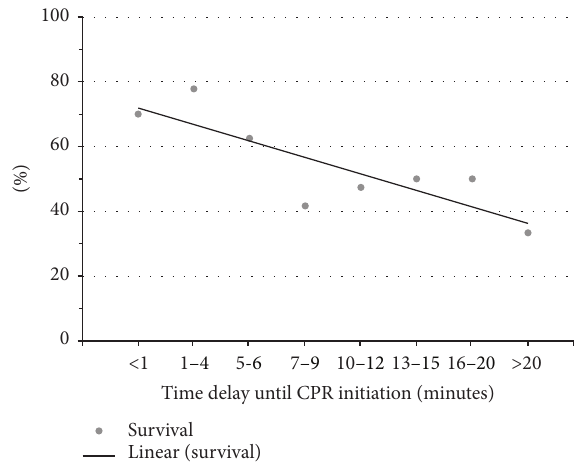
Figure 3: Effect of bystander CPR on survival. Patients were divided into those that received bystander CPR and those that did not (top pie chart). Each group was further evaluated for outcome of survival in association with having received bystander CPR (bottom right pie chart) and not having received bystander CPR (bottom left pie